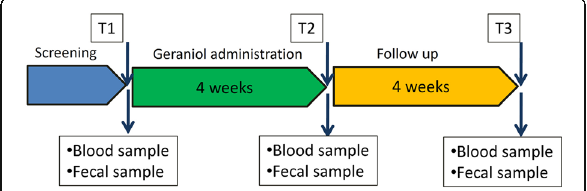
Fig. 1 Flowchart of study